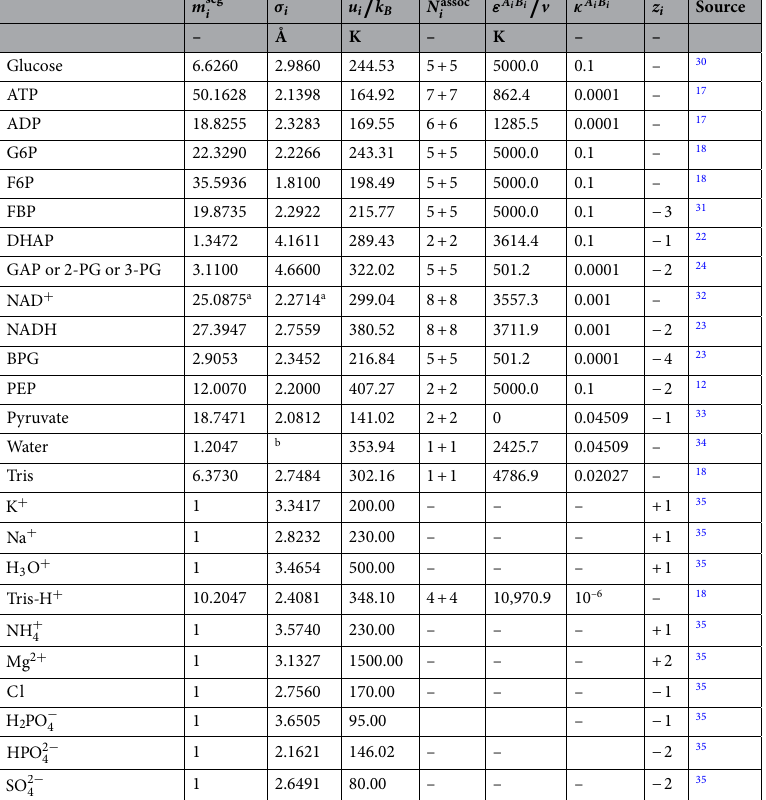
Table 2. ePC-SAFT pure-component parameters applied in this work with the sources for the respective sets of parameters. a Typo in the original reference from Wangler et al. The values given here must be used. b σ water = 2.7927 + 10.11 exp (−0.01775 T ) − 1.417 exp (−0.01146 T ) from 34